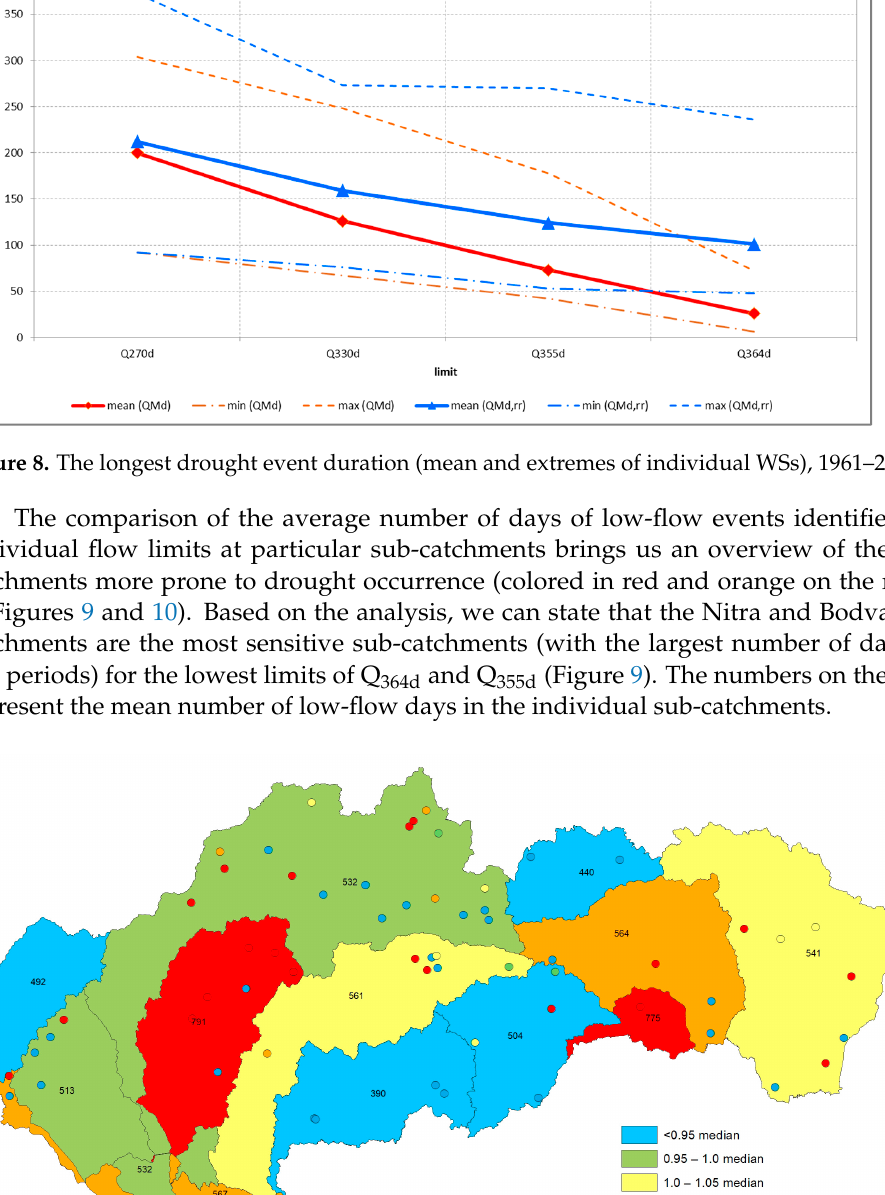
Figure 9. Sub-catchments in Slovakia colored according to the mean number of days with Q d < Q 355d ,